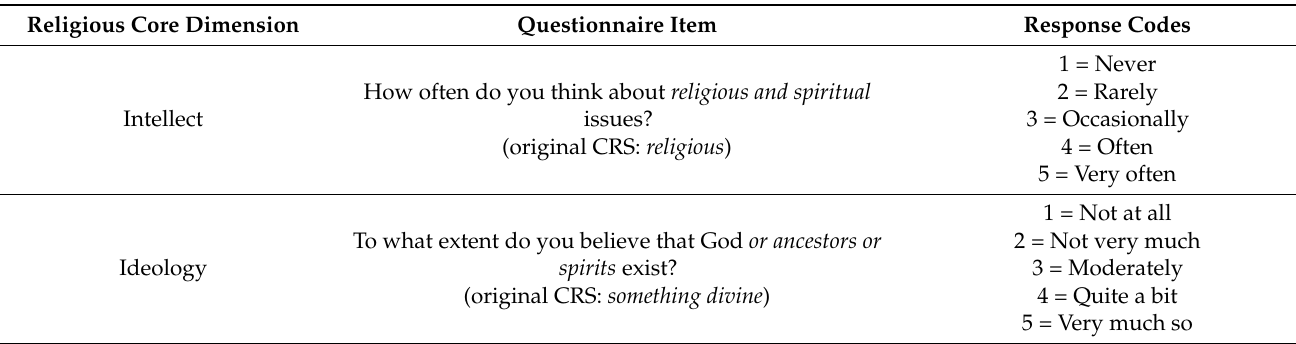
Table 3. Inventory of the Centrality of Religion